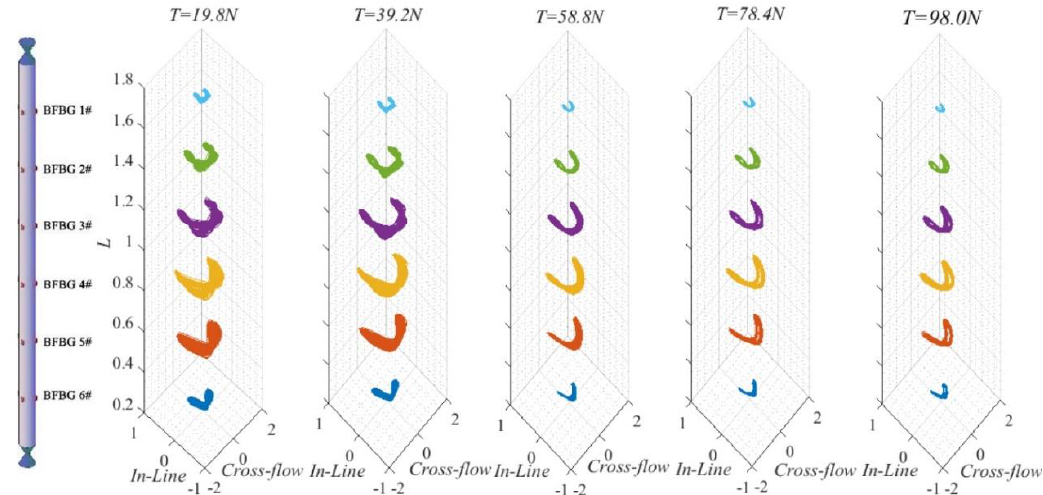
= 0.45 m / s under di ff erent top